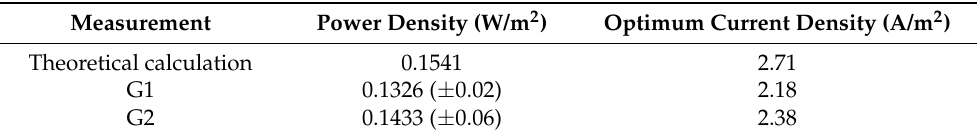
Table 4. Optimum current and power density measurements with each gasket geometry and theoret- ical calculations.